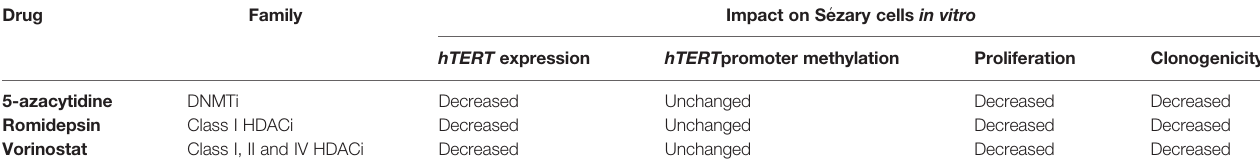
TABLE 1 | Summary of epidrugs ’ effects in Se ́ zary cells in vitro . Drug